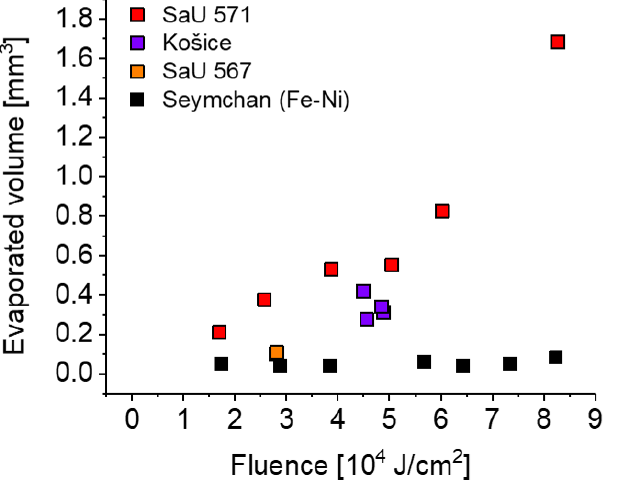
Figure 13. Dependence of the evaporated volume of several meteorite samples on the laser fluence for the PALS laser.